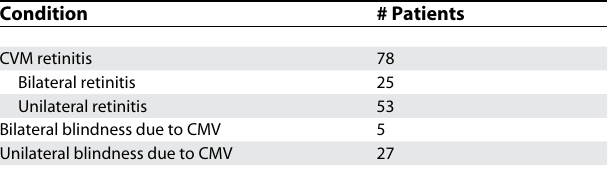
Table 2. Blindness among 78 Patients with CMV Retinitis from Cambodia, Uganda, South Africa, Thailand, and Myanmar Condition